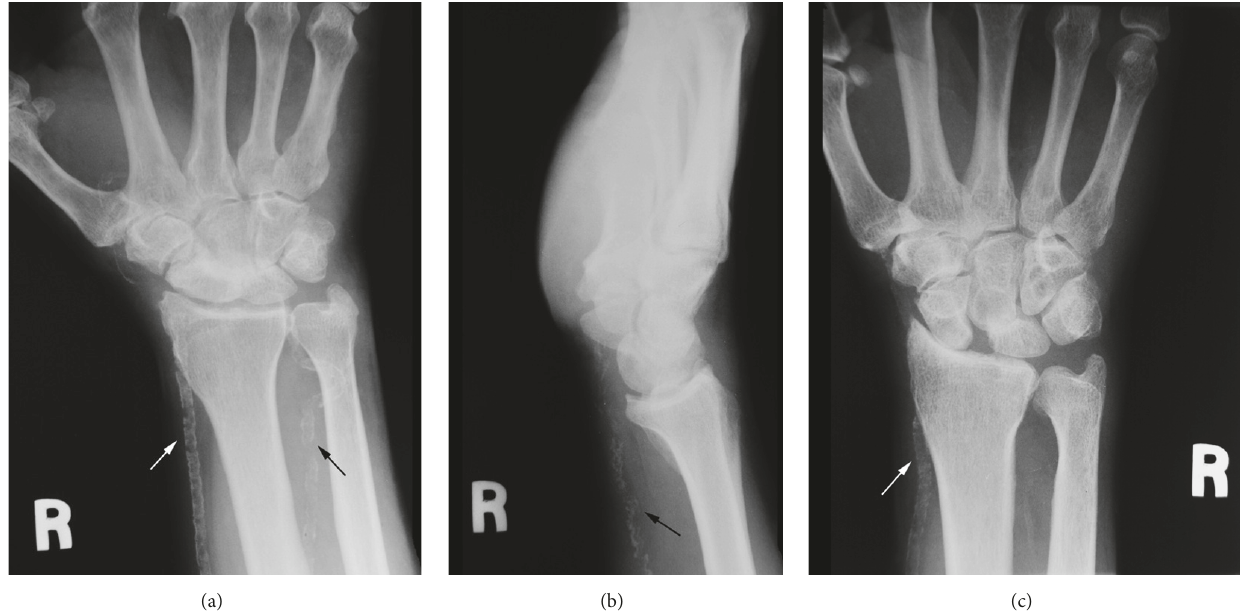
Figure 1: (a) Patient 1 with both radial artery (white arrow) and ulnar artery (black arrow) calcification. (b) Patient 2 with ulnar artery calcification. (c) Patient 3 with radial artery